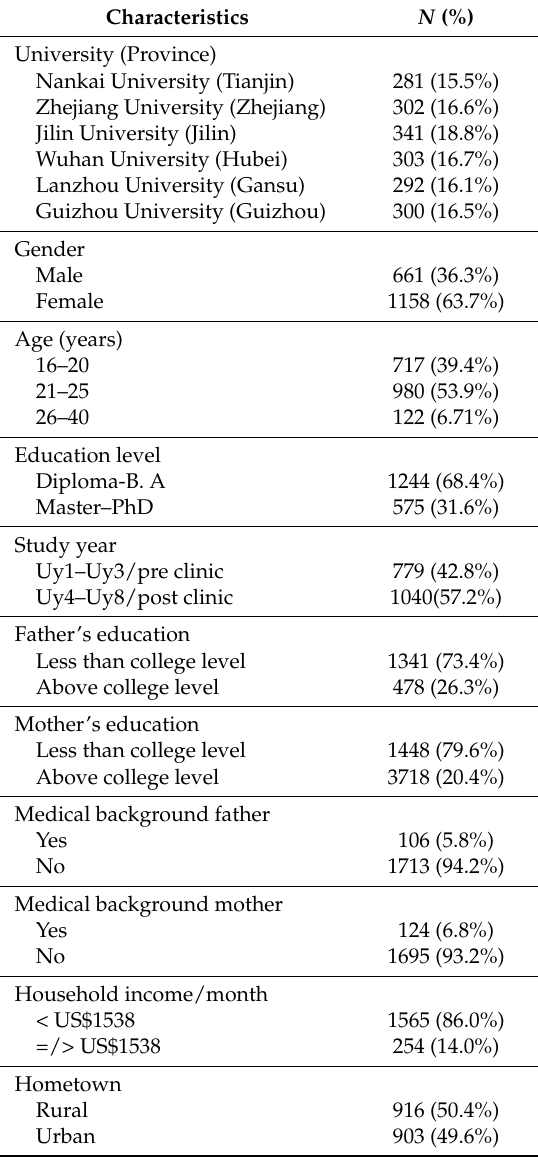
Table 2. Socio-demographic characteristics of university medical students in China in 2015 ( n = 1819).